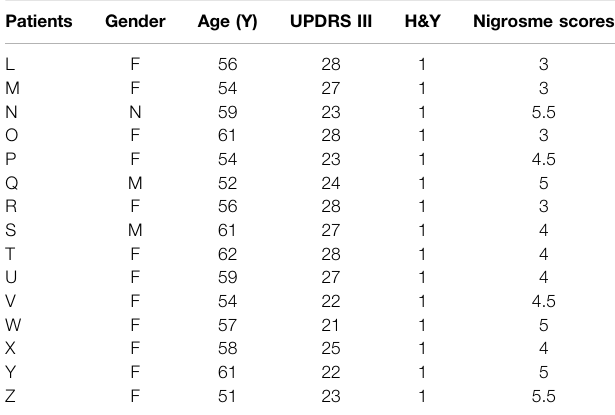
TABLE 1 | The information of PD patients who had no drug treatment with a 6 – 12 month disease duration. Patients